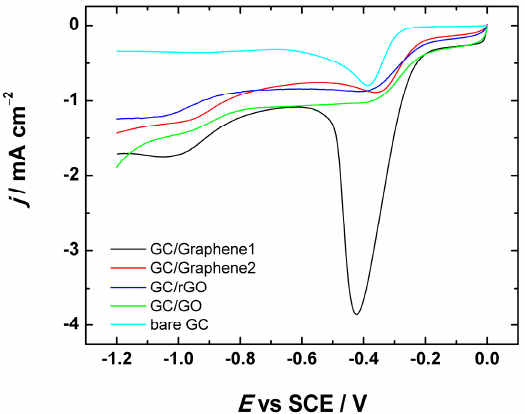
Figure 5. Comparative LSV (linear sweep voltammetry) curves for oxygen reduction on bare GC and GC electrodes coated with graphene nanopowder from Graphene Supermarket (GC/Graphene1), graphene nanoplatelet aggregates from Strem Chemicals (GC/Graphene2), reduced graphene oxide (GC/rGO) and graphene oxide (GC/GO) using suspension in 2 ‐ propanol containing OH − ionomer for the electrode preparation. LSVs were registered in O 2 ‐ saturated 0.1 M KOH at ν = 100 mV ∙ s − 1 .